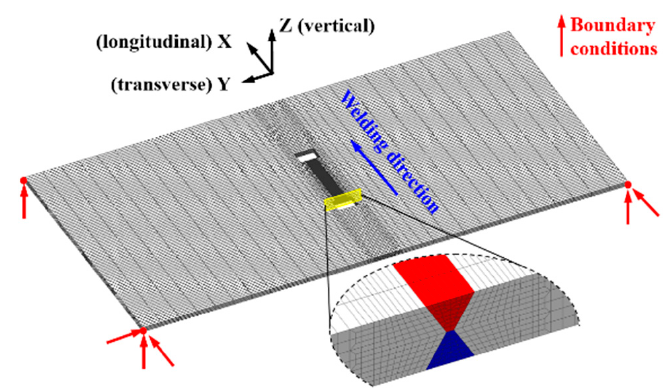
Figure 7. Finite element mesh and mechanical boundary conditions.